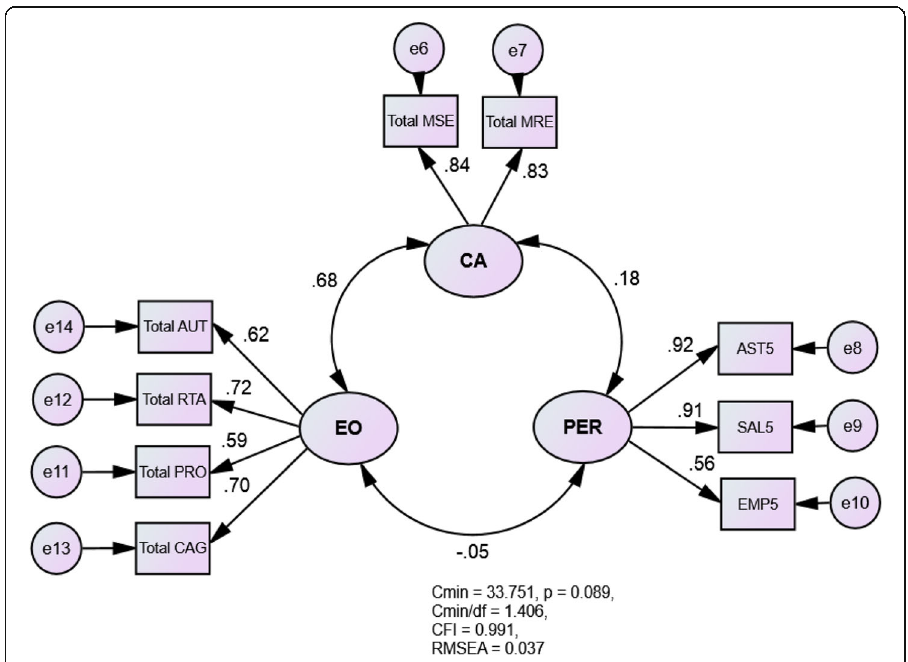
Fig. 1 Measurement model for firm growth